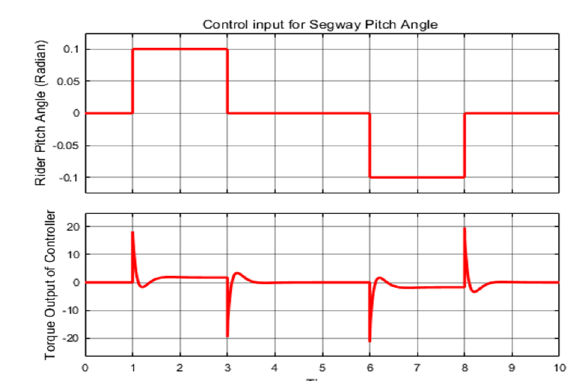
Fig. 10: Torque Output of Pitch Angle Controller for